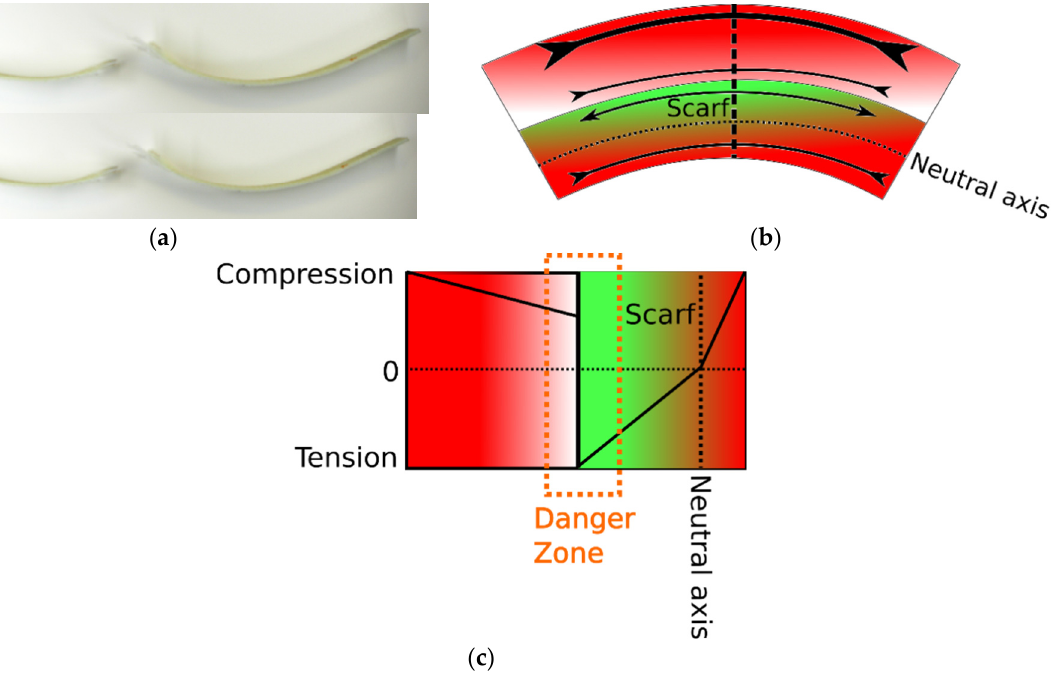
Figure 8. Curved samples ( a ) and schema of danger zones caused by residual stresses ( b ). The